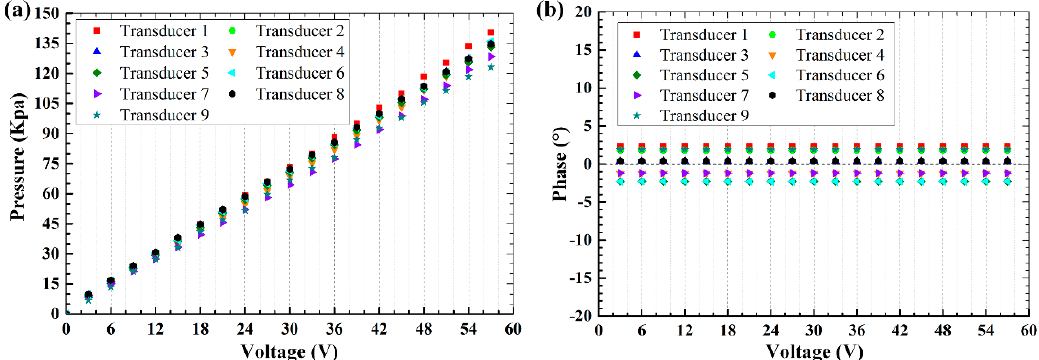
Figure 6. The measured pressure and the phase difference of each transducer at various excitation voltage. ( a ) The measured pressure. ( b ) The measured phase difference. voltage. ( a ) The measured pressure. ( b ) The measured phase